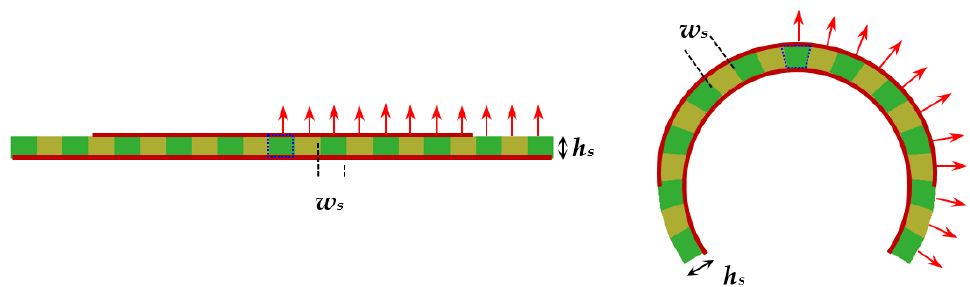
Figure 9. Flat and bent microstrip resonators on substrate constructed by sliced prisms, each with own anisotropic properties. Arrows represent the normal direction in each slice in flat and curved substrates.